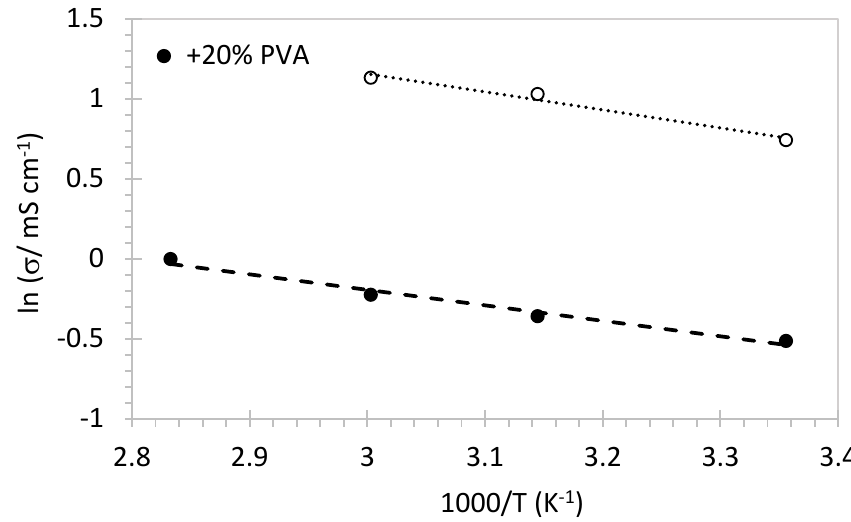
Figure 4. Arrhenius representation of conductivity data of blend membranes.